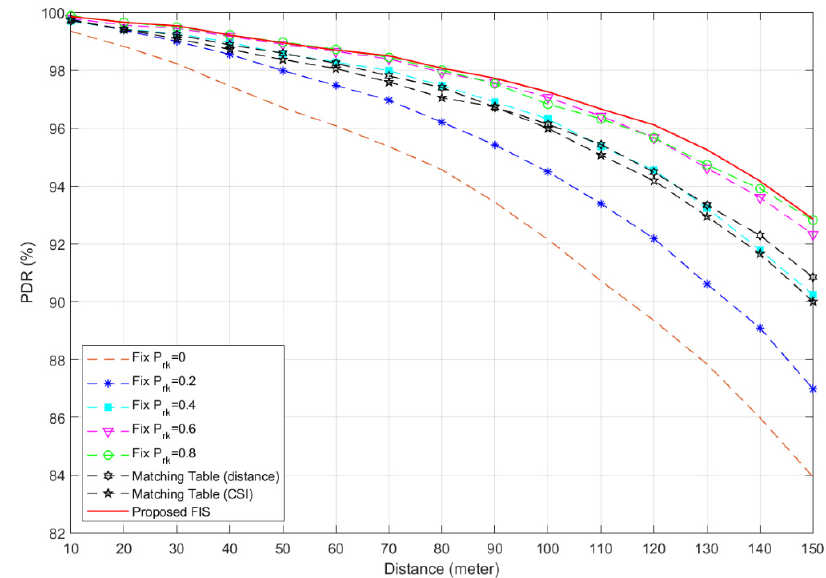
Figure 9. Overall PDR performance comparison for n V = 200 vehicle scenario.